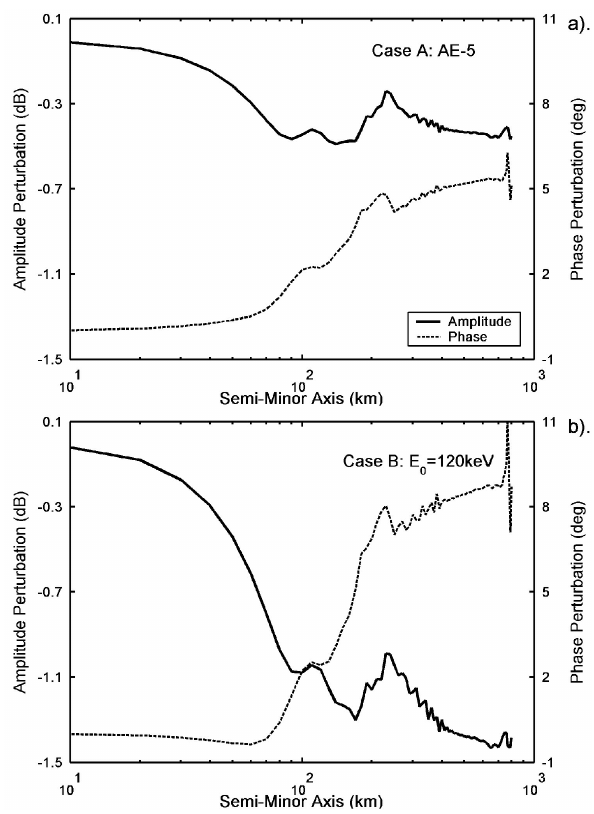
Fig. 6. Variation in the amplitude and phase of a Trimpi perturbation caused by LIEs with varying semi-minor axis sizes (a) LIE caused by a WEP burst with AE-5 energy spectra. (case A) (b) LIE caused by an e -folding energy spectra (case